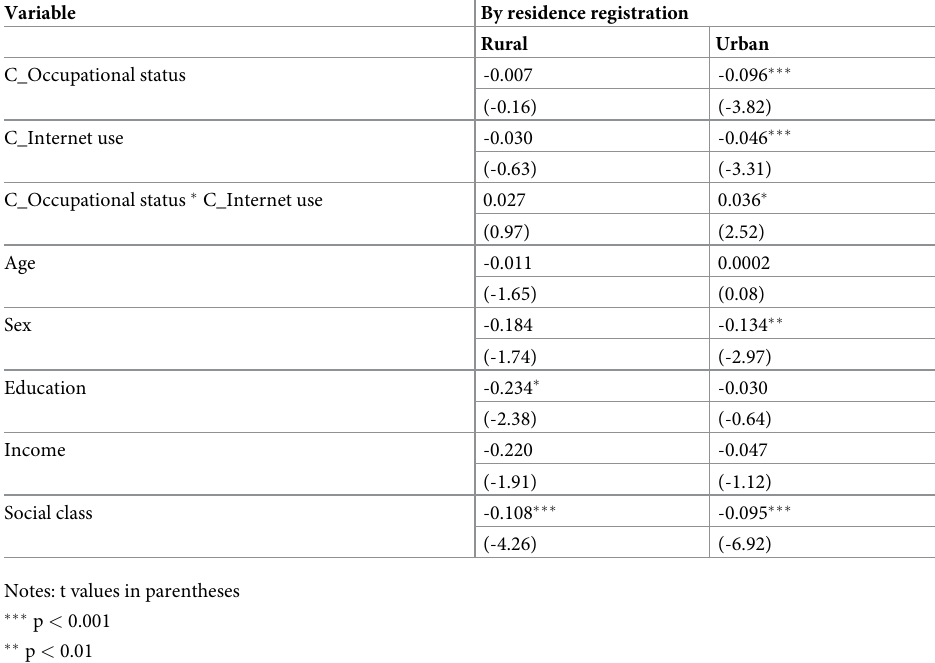
Table 5. Residence registration heterogeneity analysis (N =